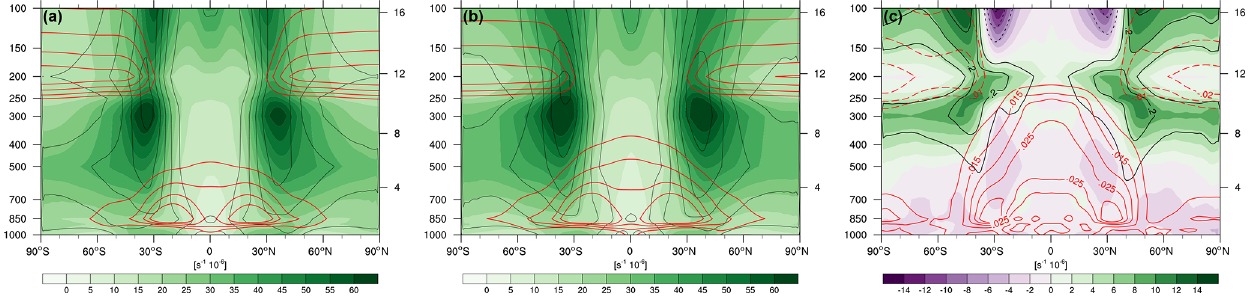
Figure B2. Zonal mean baroclinicity (green shading; s − 1 × 10 − 6 ), meridional potential temperature gradient (black contours; K(100km) − 1 ), and the dry static stability normalized by the scale height (red contours; K 2 m − 2 s 2 ) in the (a) control and (b) control + 4K simulations and (c) their